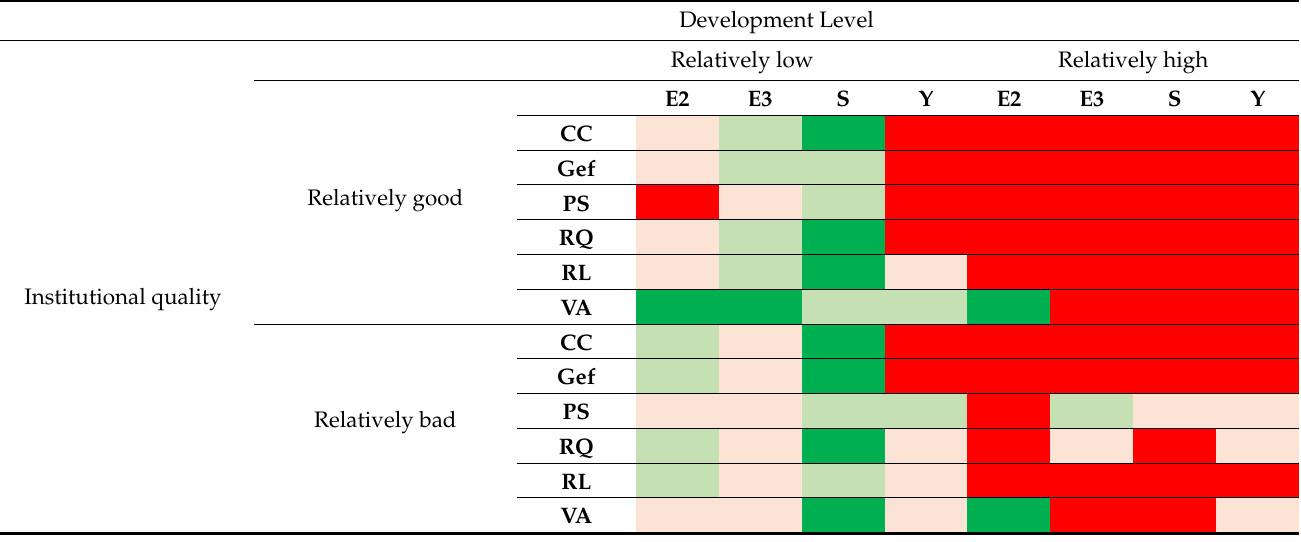
Table 2. The impact of financialisation on long-run economic growth, which is mediated by institutional quality, level of development, and their